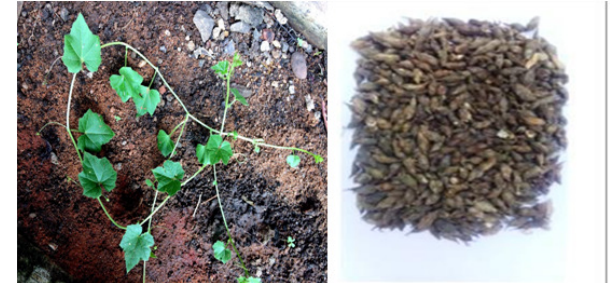
Fig. 1. Momordica cymbalaria